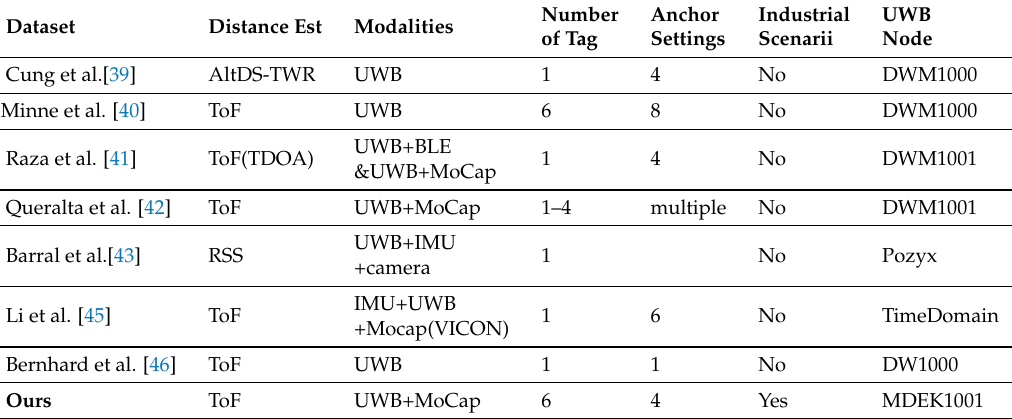
Table 3. Comparison of existing UWB-based localization and positioning datasets and